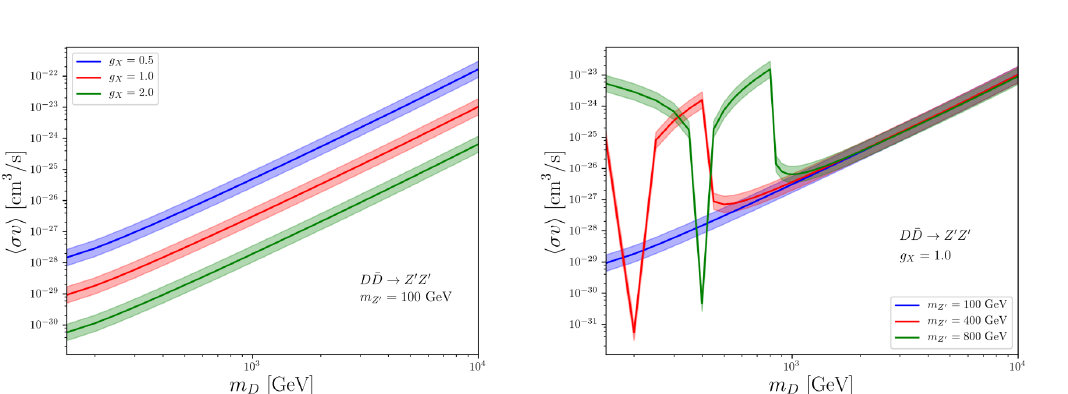
Figure 1 . The 90% upper limits on the thermally averaged cross section using the Fermi-LAT data [94] for Z 0 Z 0 final state. We show the limits for different g X values (left panel) and different m Z 0 (right panel) with the 1 σ uncertainty